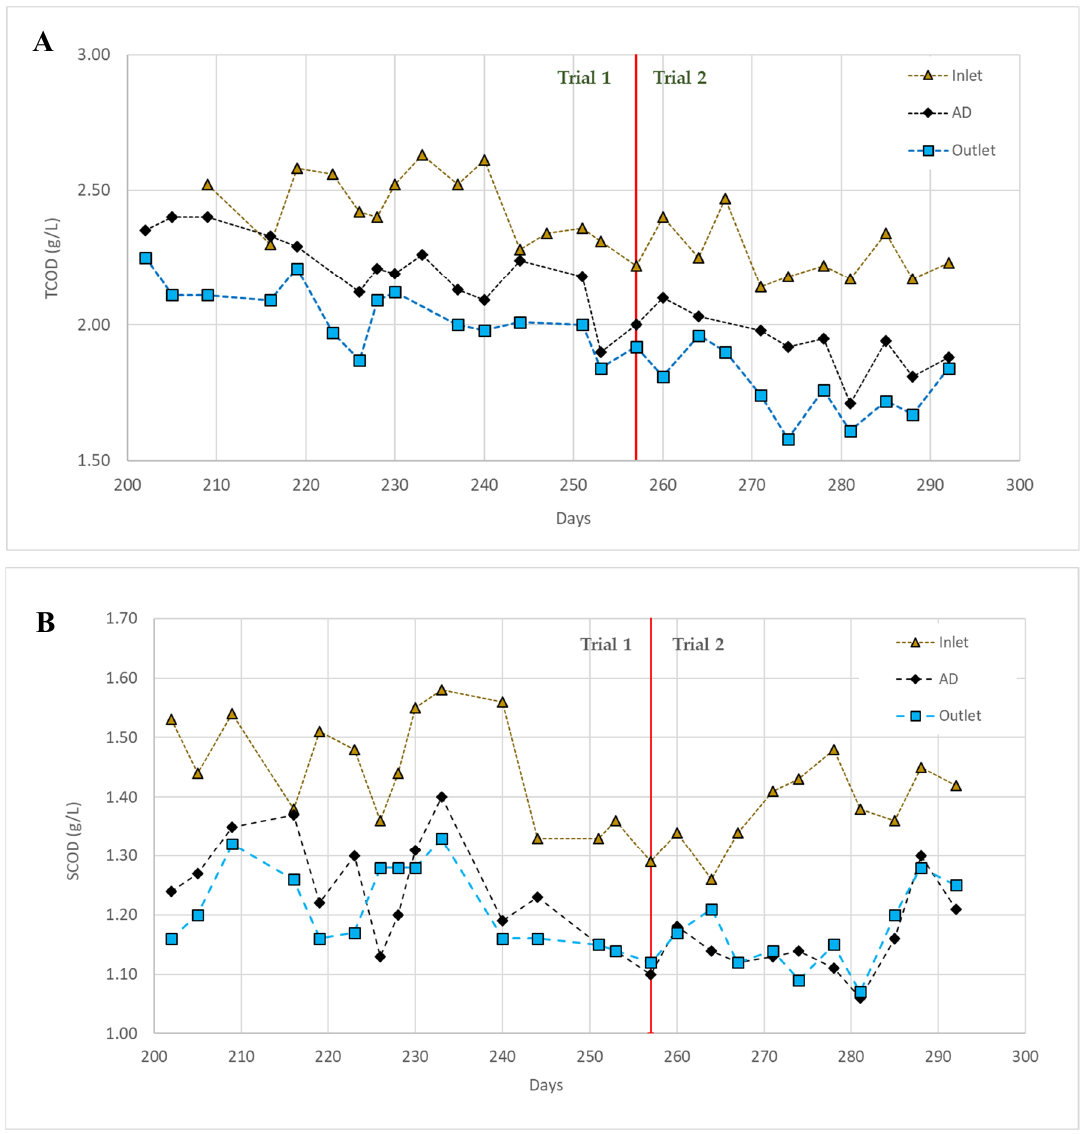
Figure 7. Inlet, anaerobic digestion (AD), and outlet concentration of total chemical oxygen demand (TCOD) ( A ) and soluble chemical oxygen demand (SCOD) ( B ).